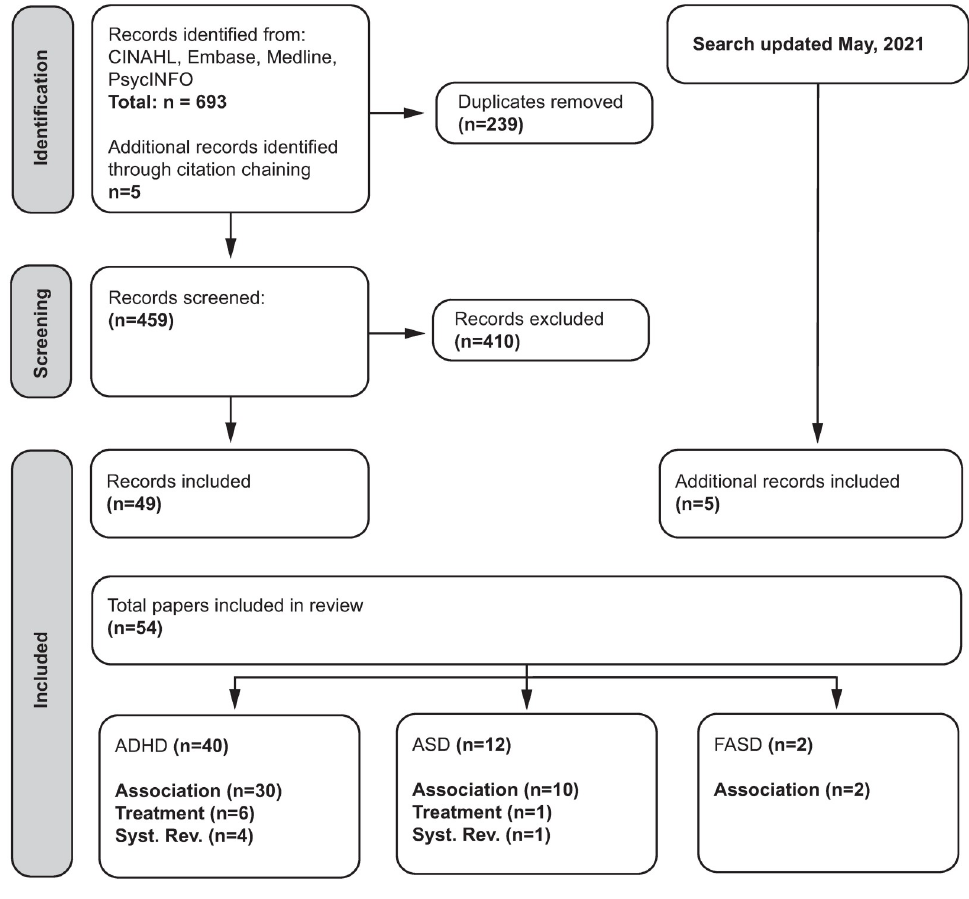
Fig 1. Scoping review flow